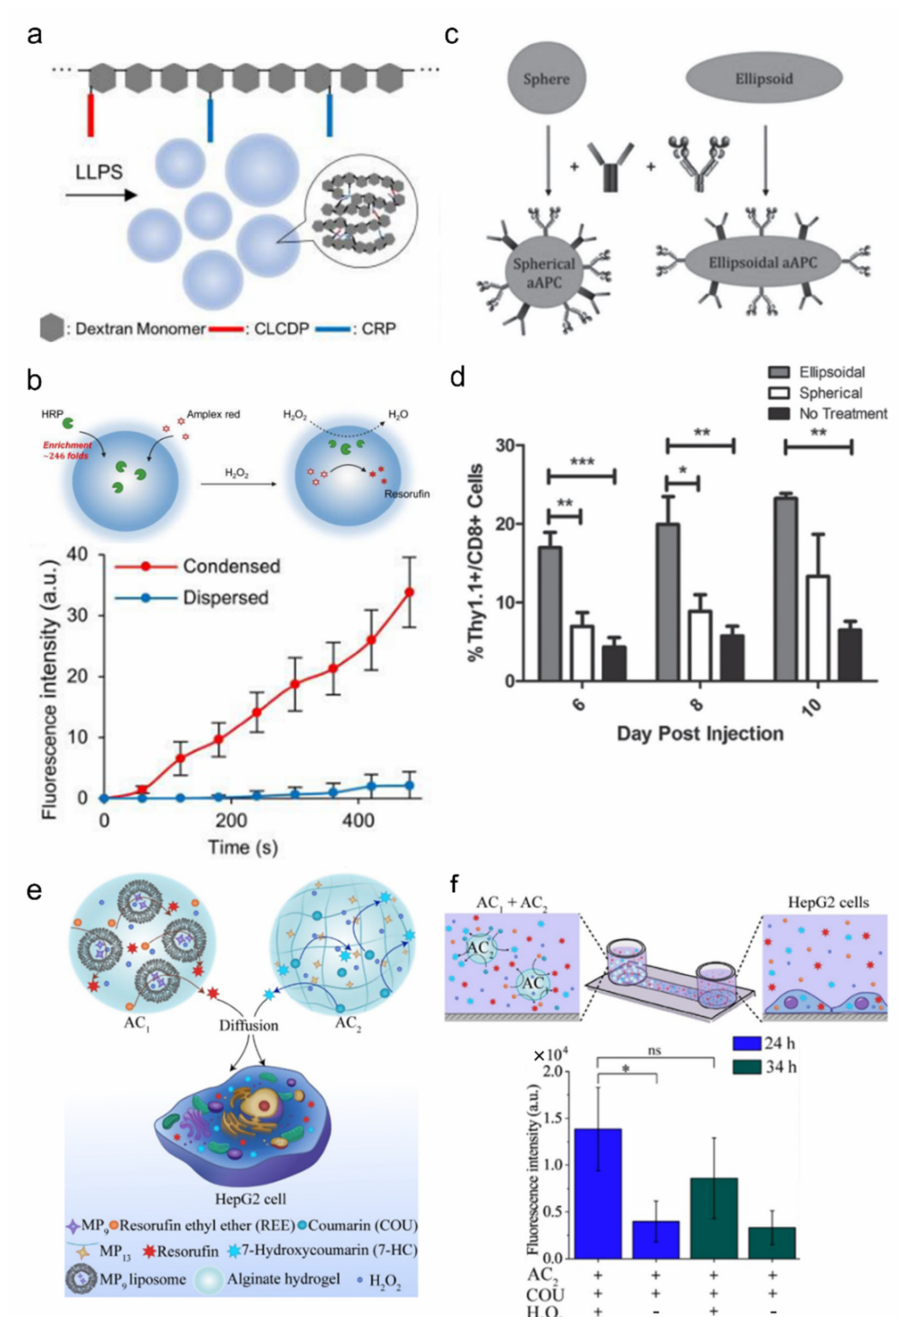
Figure 7. Examples of hydrogel-based artificial cells. ( a , b ) Liquid–liquid phase separation using polymer–peptide hybrid. ( a ) Oligopeptides were used as stickers while dextran backbones